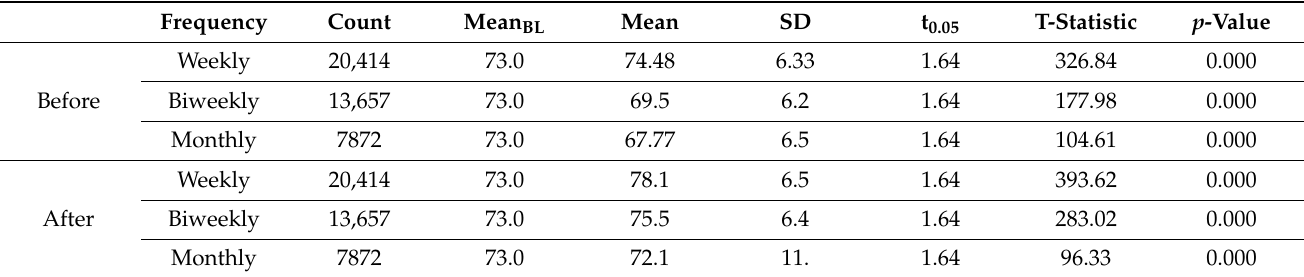
Table 5. One-tailed t -test of SR measurement-water